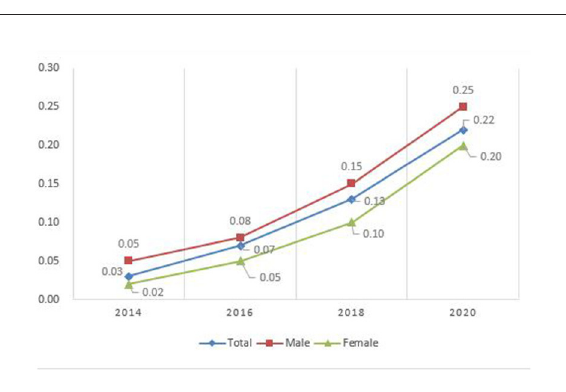
FIGURE1 Changing trend of Internet usage frequency among the